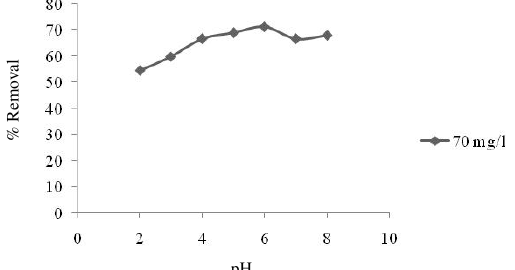
Figure 2. Effect of pH on removal % of lead: 0.2 g adsorbent agitated at 150 rpm with 50 mL solution of 70 mg/L lead at 30